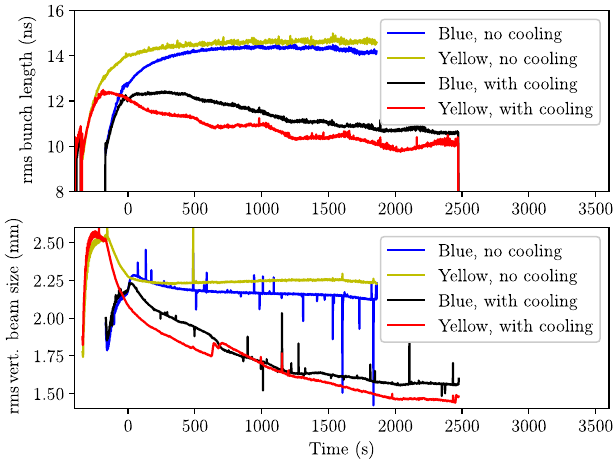
FIG. 5. Ion beam emittance evolution, with and without electron cooling. Upper plot: rms bunch length. Lower plot: vertical beam size. The blue and yellow traces are without cooling, while the black and red traces are with cooling. The Yellow beam was injected about 3 min before the Blue beam. The time origin marks the start of physics data taking, soon after both rings were filled.